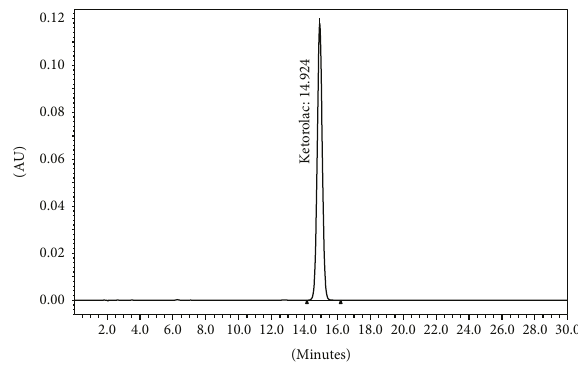
Figure 3: Chromatogram for the reference solution of ketorolac.